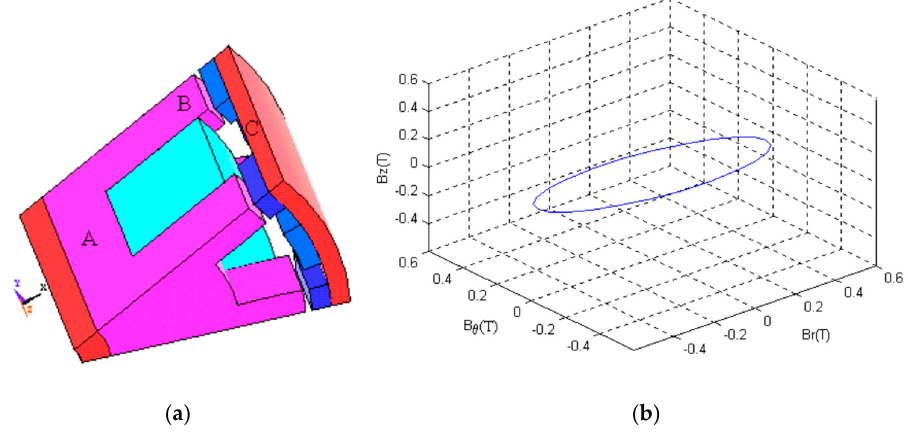
Figure 4. Magnetic field finite element analysis: ( a ) two pole-pitches for numerical analysis, and ( b ) magnetic flux density locus at Point B when the rotor has rotated by 360 electrical degrees.